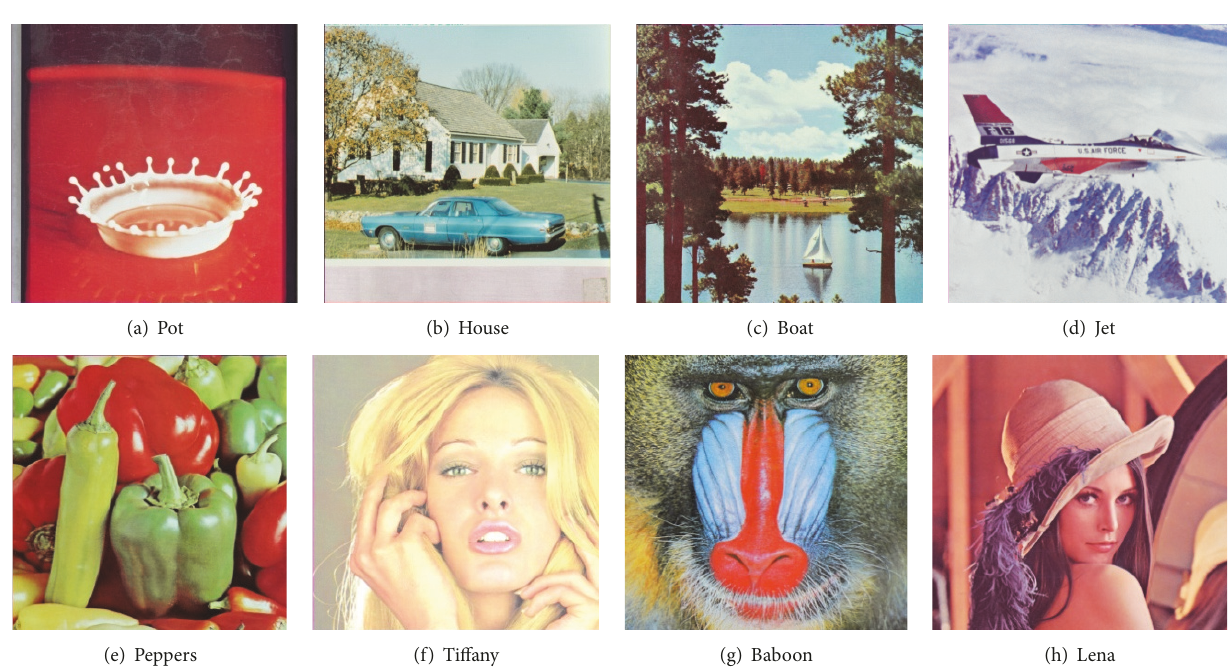
Figure 4: Original